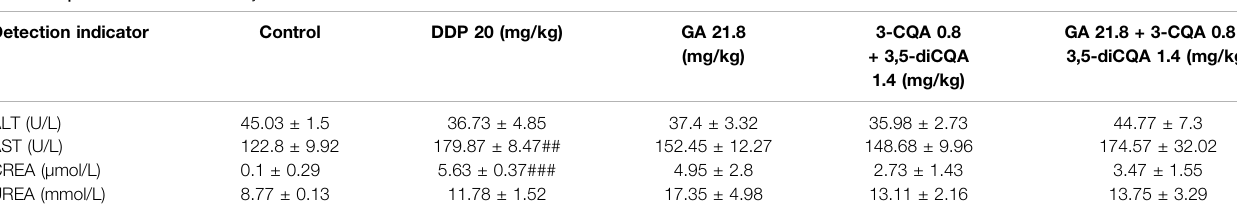
TABLE 9 | Blood biochemical analysis. Detection